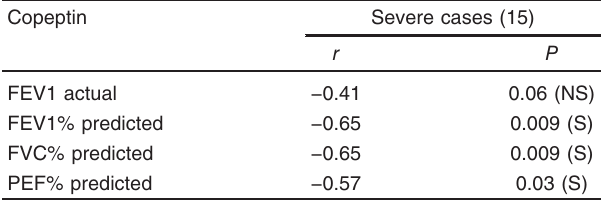
Table 8 Correlation between copeptin and pulmonary function tests in severe disease group Copeptin Severe cases (15)